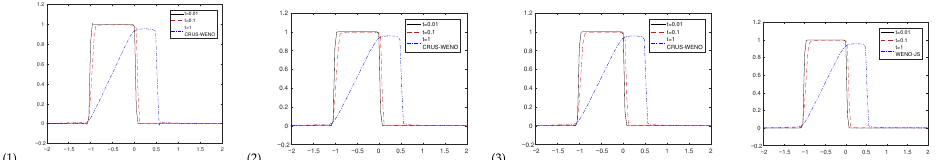
Figure 2. Example 4: Numerical solutions of the CRUS-WENO scheme with different linear weights ( 1 )–( 3 ) and the WENO-JS scheme at β =